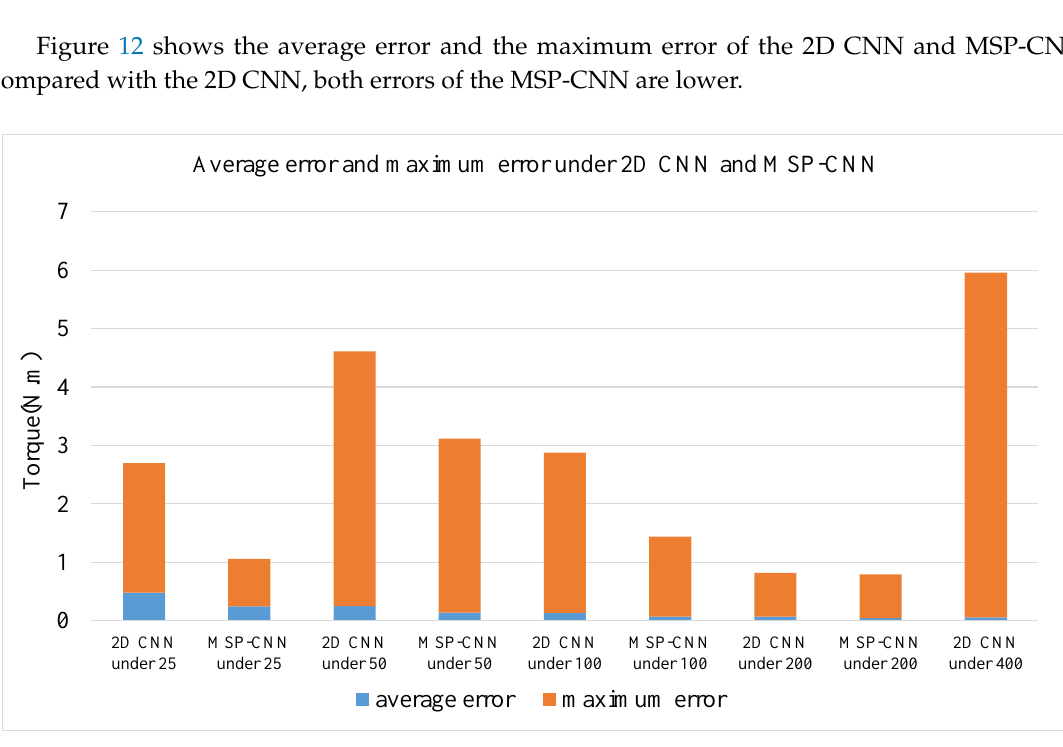
Figure 12. Average error and maximum error of MSP-CNN and 2D CNN.